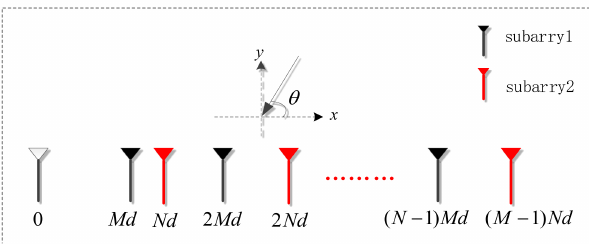
Figure 2. Geometry of coprime array.